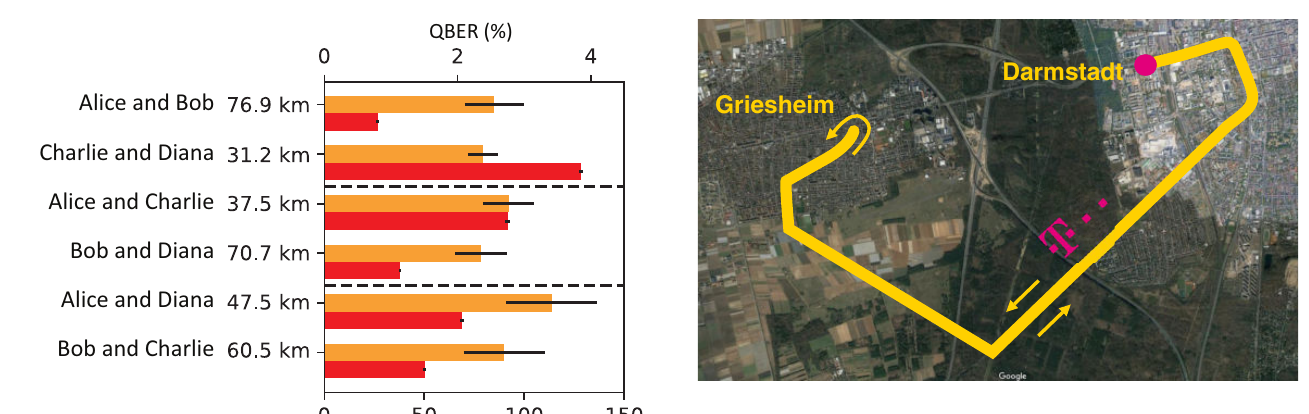
FIG. 8. The deployed standard single mode dark-fiber link of Deutsche Telekom for the field test. The link consists of a looped fiber running from the Deutsche Telekom facility in Darmstadt to Griesheim and a parallel fiber running back to Darmstadt. The fiber length is 26.8 km, with a total loss of 6.7 dB. (Google Maps 2021